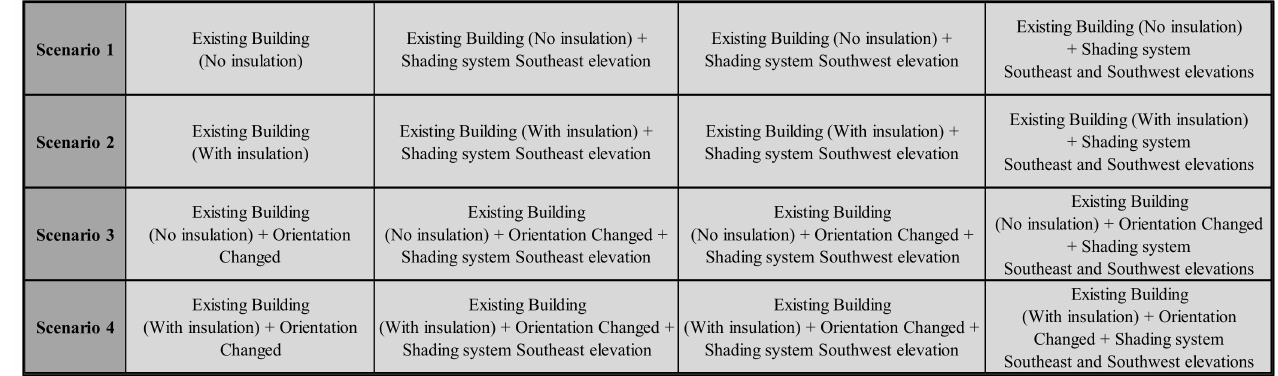
Figure 7. Simulations of the building performance divided in four